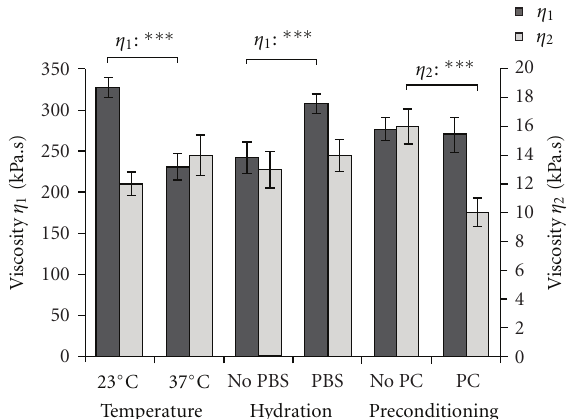
Figure 7: Viscosities of ring-shaped collagen gels as a function of temperature (experiments performed either at 23 ◦ C or 37 ◦ C), hydration (either with or without a PBS solution), and mechanical preconditioning (either with or without mechanical precondition- ing PC). Viscosities η 1 and η 2 are extracted from the first and the second term of the second-decay exponential regression of stress-strain relaxation curves obtained on collagen gels. Values are expressed as mean ± standard error. Significance: ∗ P < 0 . 05; ∗∗ P < 0 . 01; ∗∗∗ P < 0 .